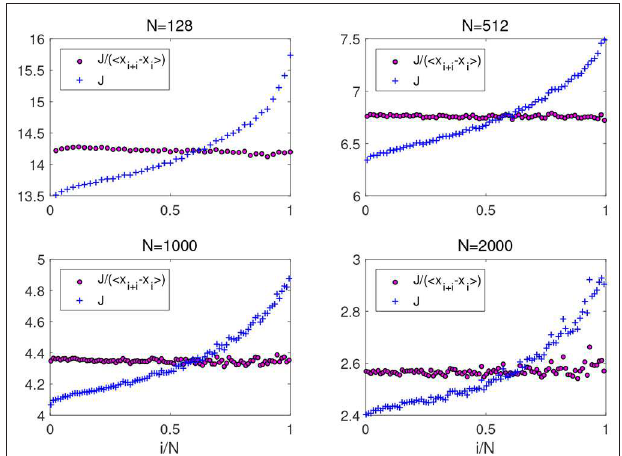
) defined by + 128, 512, 1,000, 2,000) and =